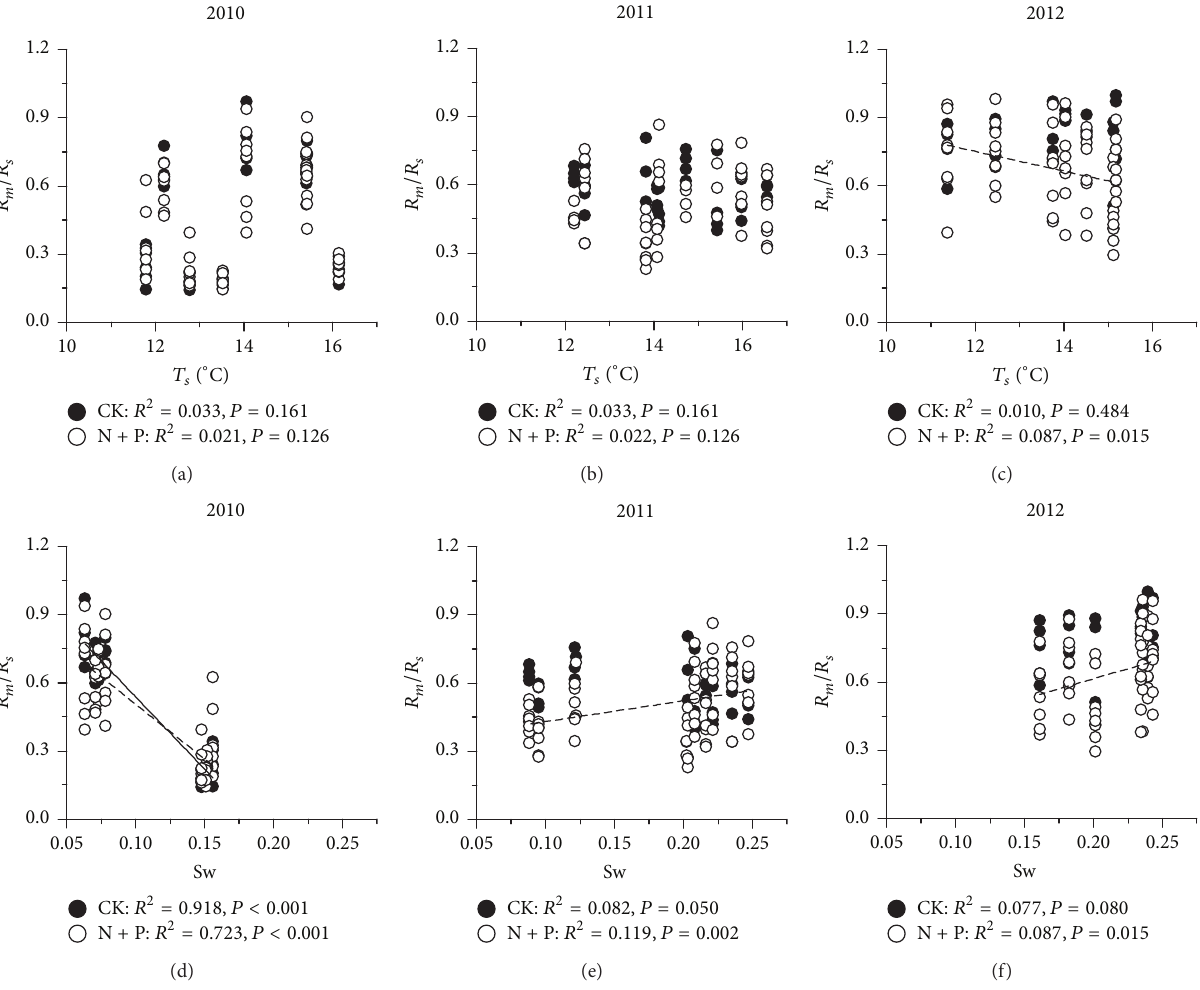
Figure 4: Relationships of contribution of soil microbial respiration ( 𝑅 𝑚 ) to soil respiration ( 𝑅 𝑠 ) with soil temperature and soil moisture in 5 cm depth under CK (soild circles) and combination of N and P treatments (including LN + P and HN + P treatments, open circles) in 2010, 2011, and 2012, respectively. See Figure 1 for